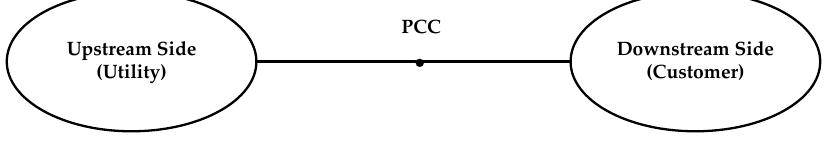
Figure 1. Equivalent interpretation of distribution system at the PCC.